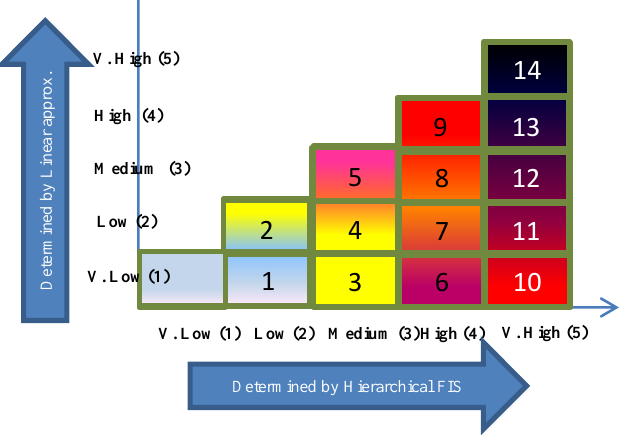
Figure 5. Quantifying risk index using hybrid